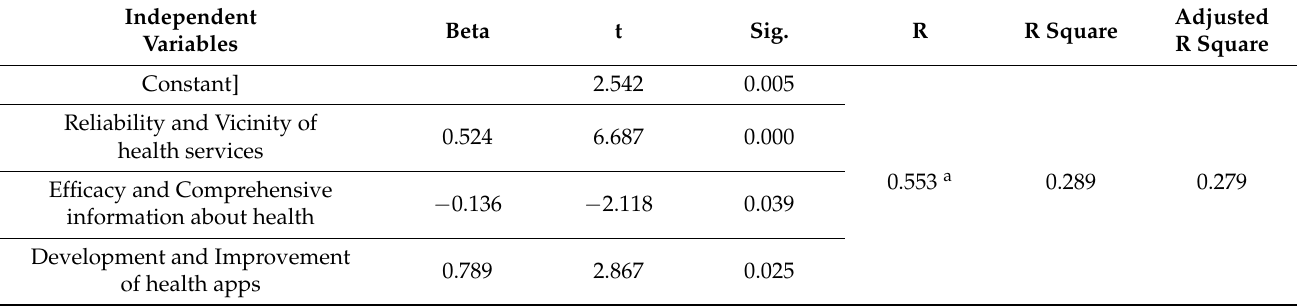
Table 2. Regression